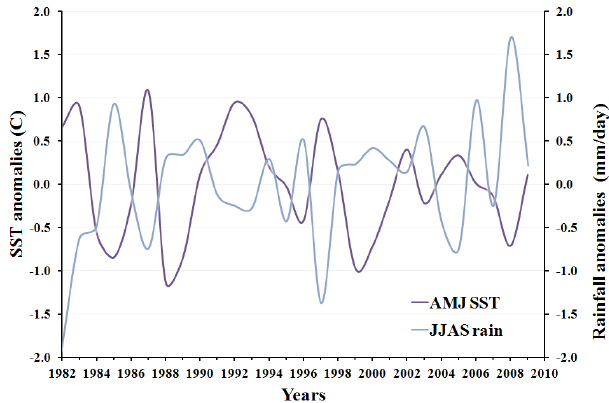
Figure 12. SST anomalies during AMJ in the Niño 3.4 region and ensemble average Reg-TB rainfall anomalies in the upper catch- ment of the Blue